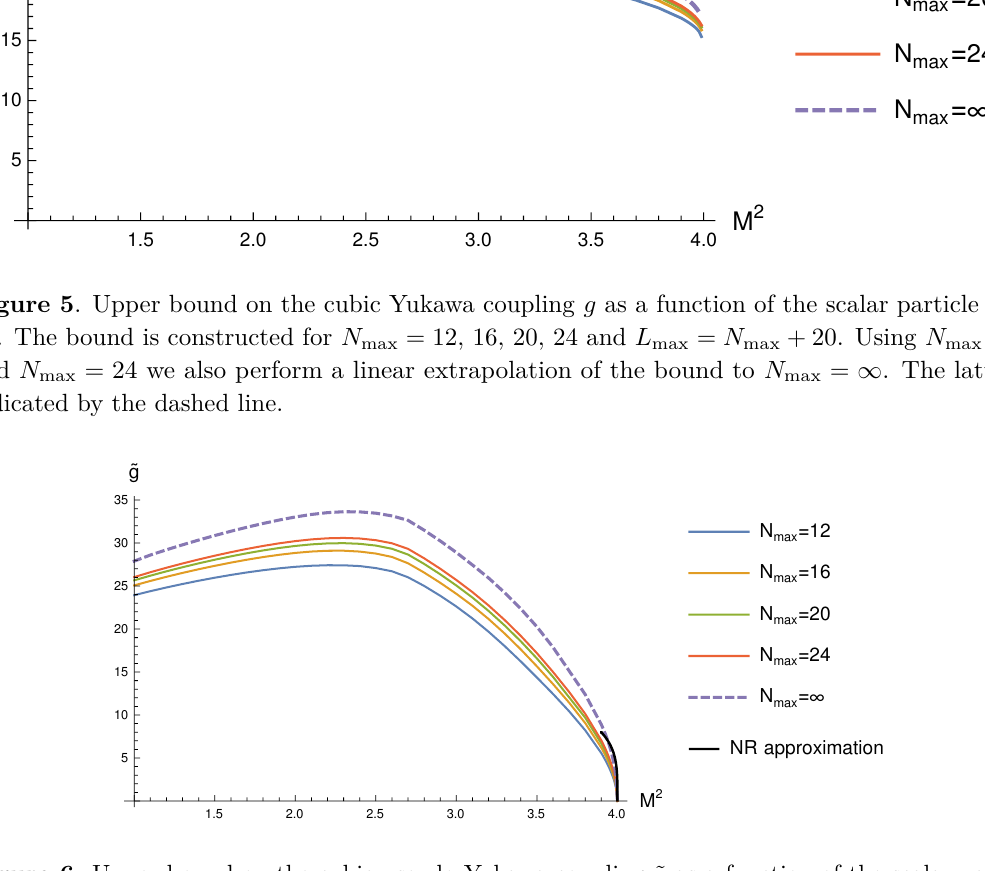
Figure 6 . Upper bound on the cubic pseudo-Yukawa coupling ˜ g as a function of the scalar particle mass M . The bound is constructed for N max = 12 , 16 , 20 , 24 and L max = N max + 20 . Using N max = 20 and N max = 24 we also perform a linear extrapolation of the bound to N max = ∞ . The latter is indicated by the dashed line. The black line indicates an analytic prediction for the upper bound in the vicinity of M 2 = 4 computed in